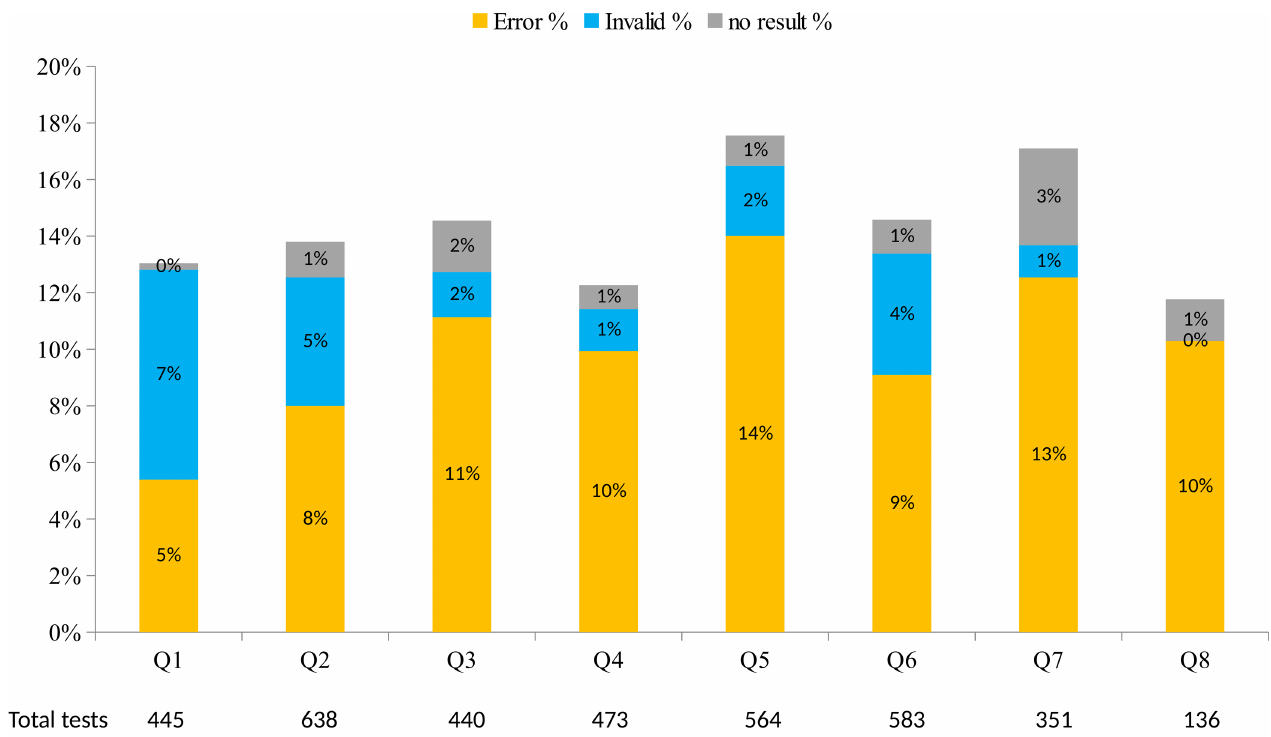
Fig 2. Error, invalid, and no result rates by quarter following initial implementation October 2012 to November2014. Error rates showed increasing trend over 8 quarters, p = 0 . 008 .Invalidrates showeddecreasing trend over 8 quarters, p < 0 . 001 .No result showedincreasing trend over 8 quarters, p = 0 . 099 .Note for Fig 2. By the time of analysisall 13 sites have experienced at least four quarters. Q5 –elevensites (ATH, WC, BOB, BK8, DRM, EXT, GAN, KAD, LMH, NRH and SDA). Q6 –ten sites (ATH, AWC, BOB, BK8, DRM, GAN, KAD, LMH, NRH and SDA). Q7. Five sites (ATH, AWC, BK8, KAD and LMH). Q8 –two sites (ATH and